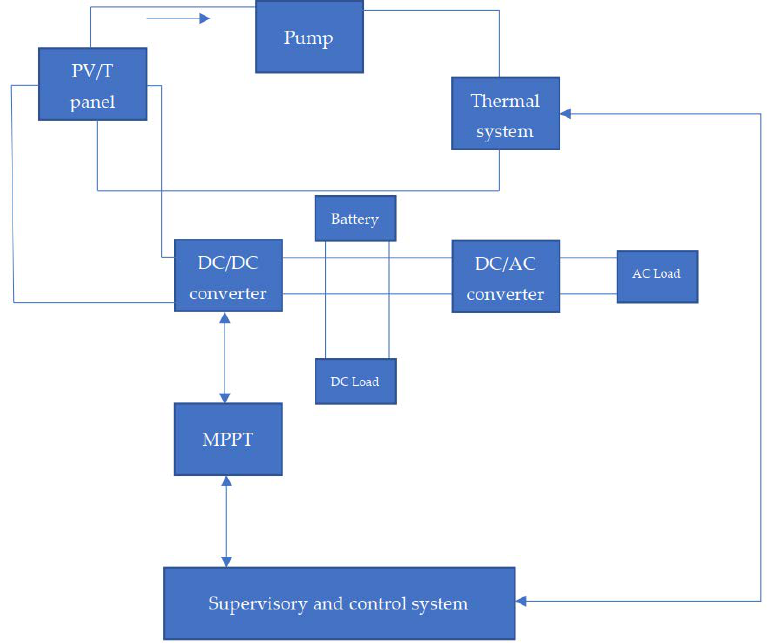
Figure 1. The demonstration of the proposed PV/T system.